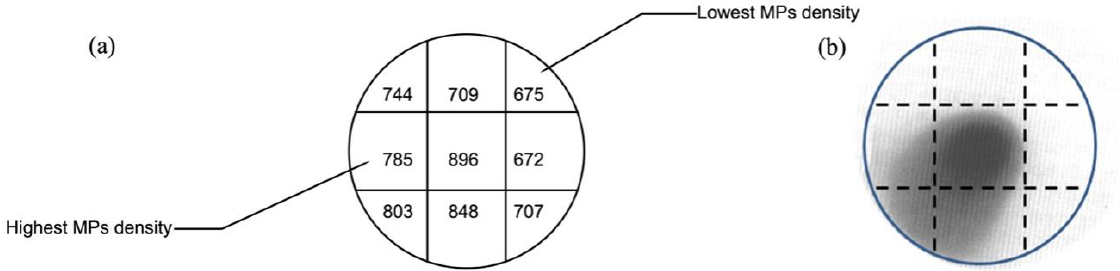
Figure 8. Schematic diagram of an Si wafer showing ( a ) the distribution of the film thickness and ( b ) corresponding plasma density distribution.